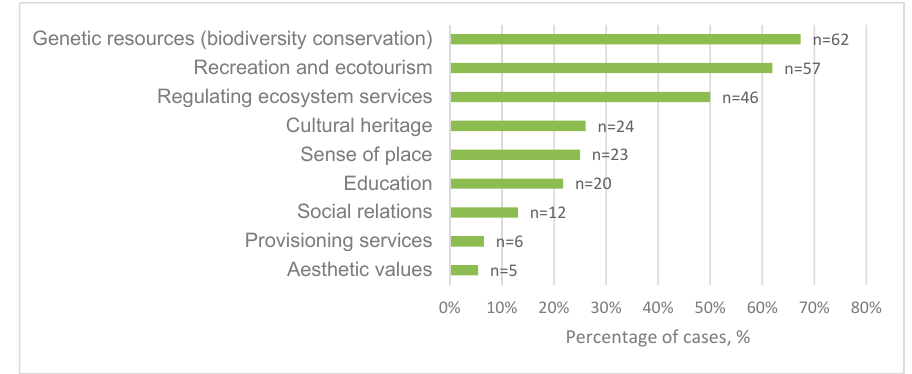
Figure 3. Aims of landscape corridor cases.